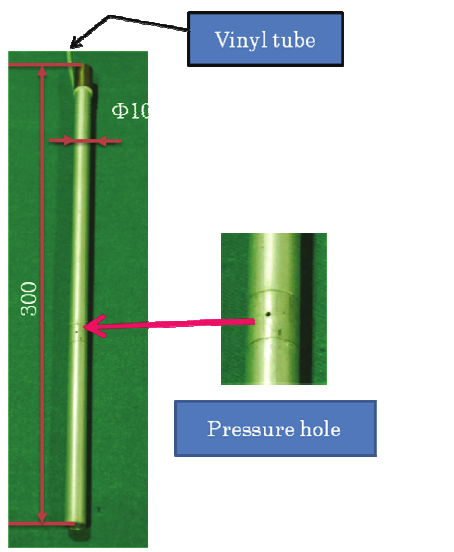
Fig. 2. Test circular cylinder for pressure measurement